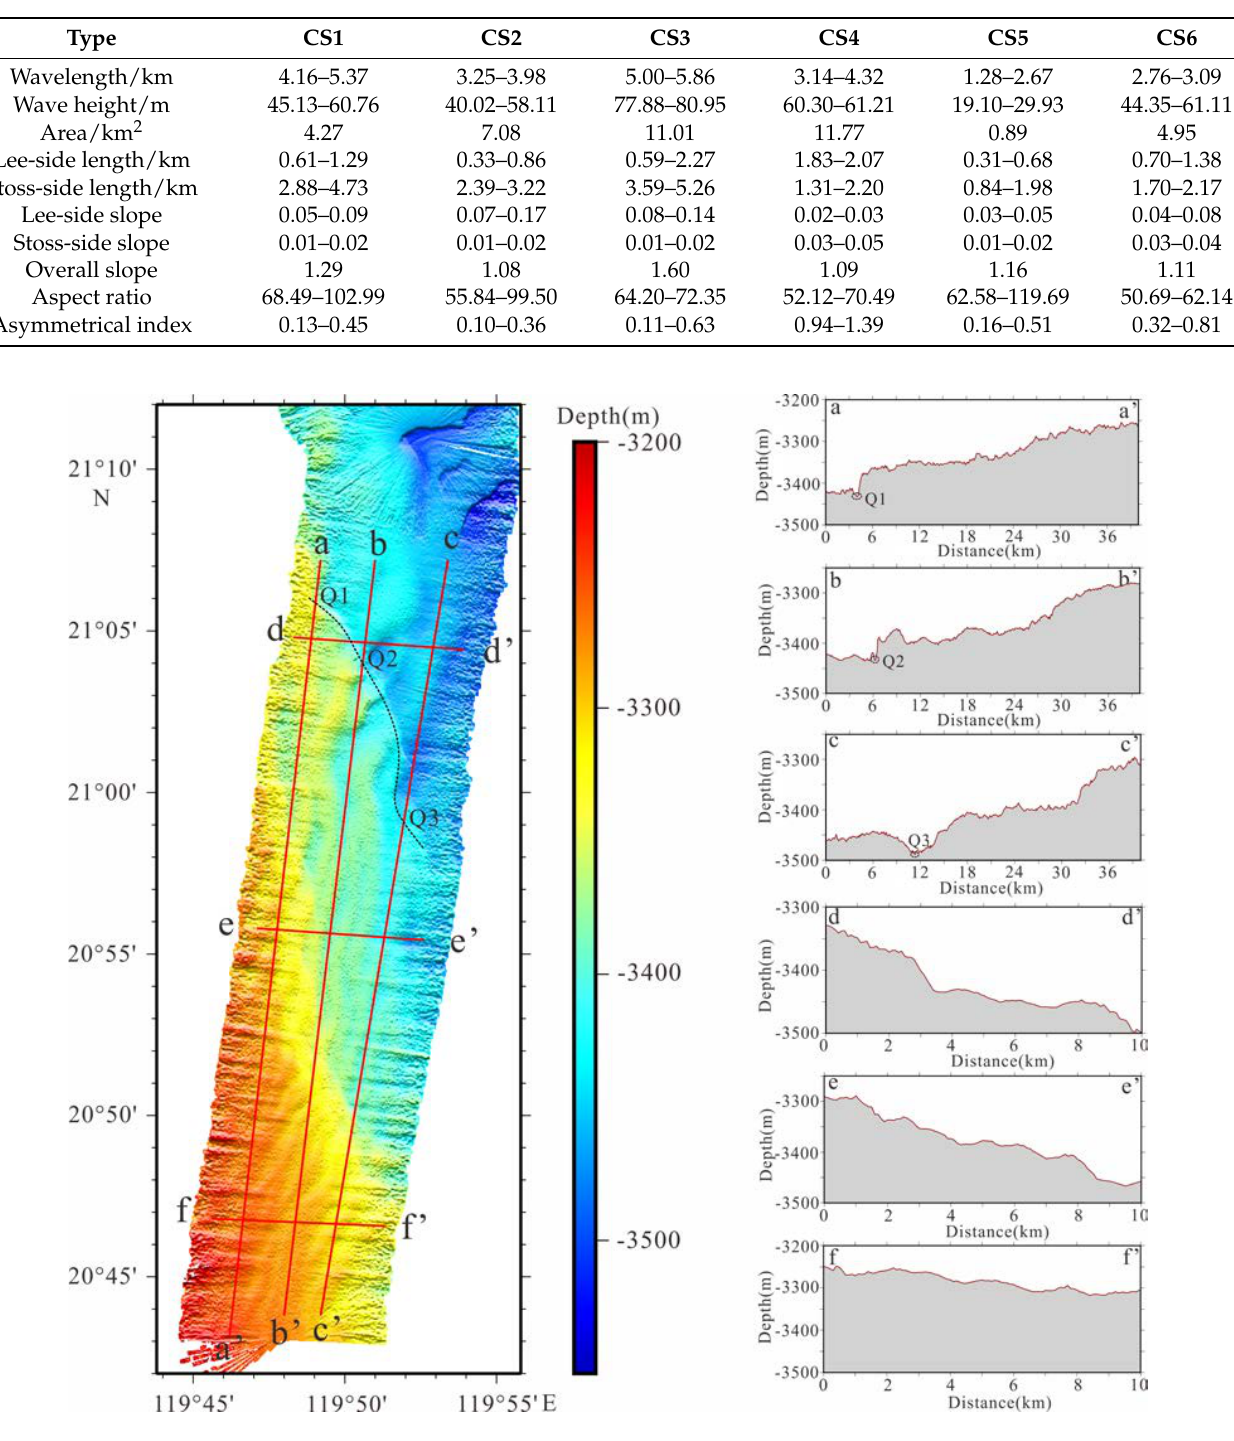
Table 1. Morphological parameters of six cyclic steps identified in the lower section of the Penghu canyon.